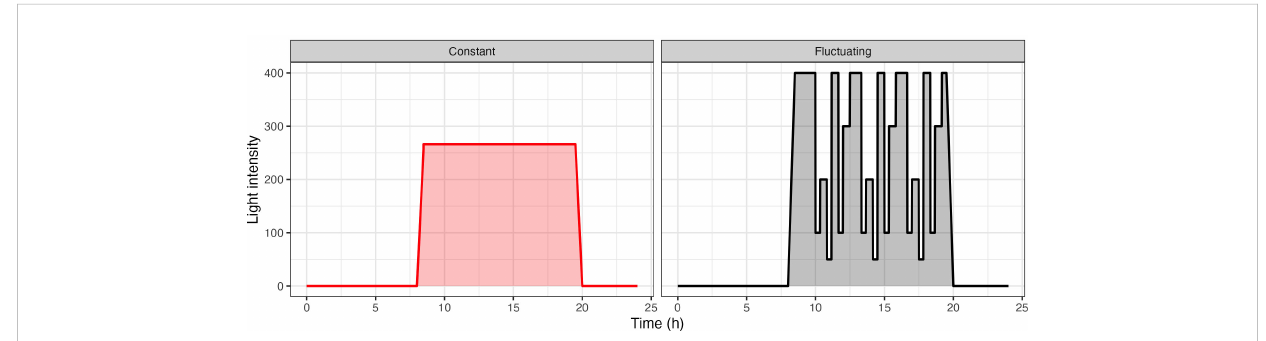
FIGURE 1 Light patterns used for the analysis of acclimation in Arabidopsis thaliana . Plants were split into two groups and were subject to two different light treatments: Constant Light (CL: red) versus Fluctuating Light (FL: